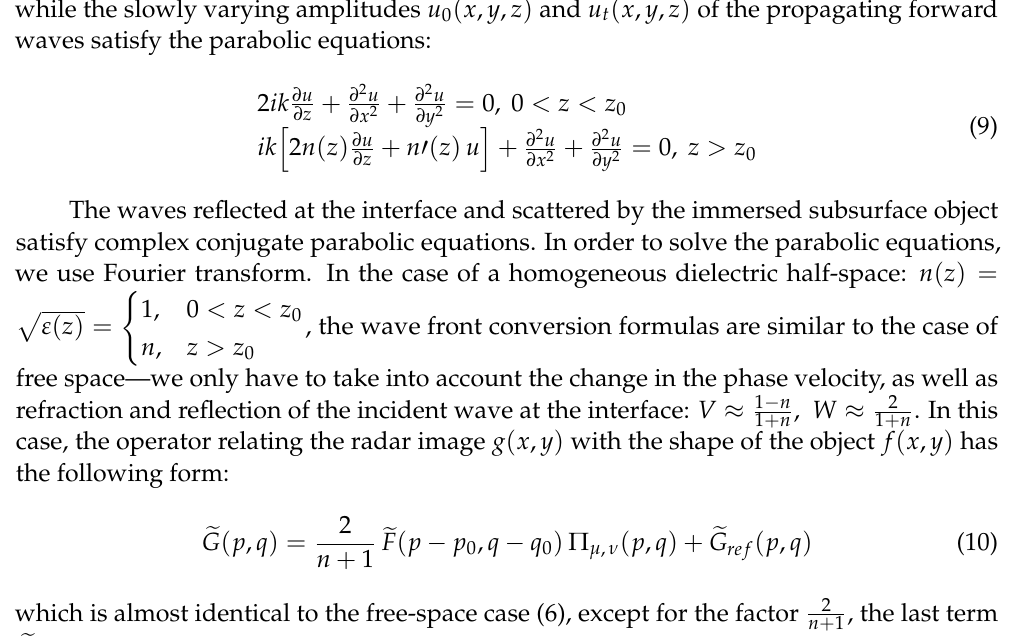
Figure 11. Spatial spectrum of the test object ( a ) and superposition of four holographic image spectra taken with four different angles of illumination ( b ) and synthesized image of the object ( c ).